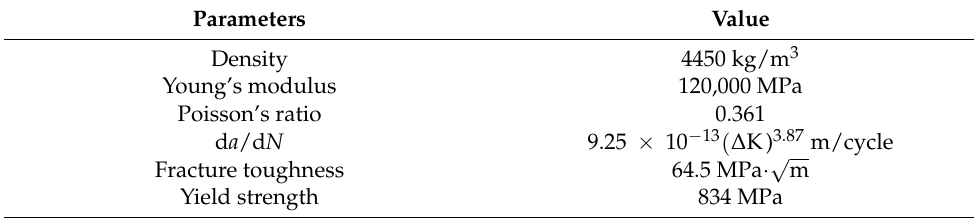
Table 1. Boundary conditions in the steady state [35].